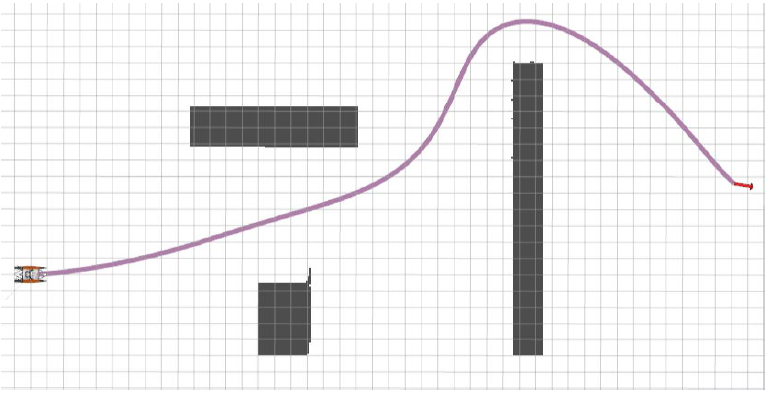
Figure 5. Global trajectory generation performance of the USV-UAV cooperative